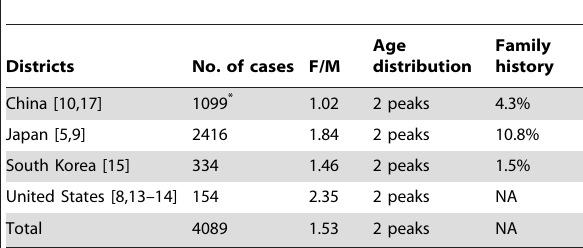
Table 2. Comparison of MMD in different districts. a